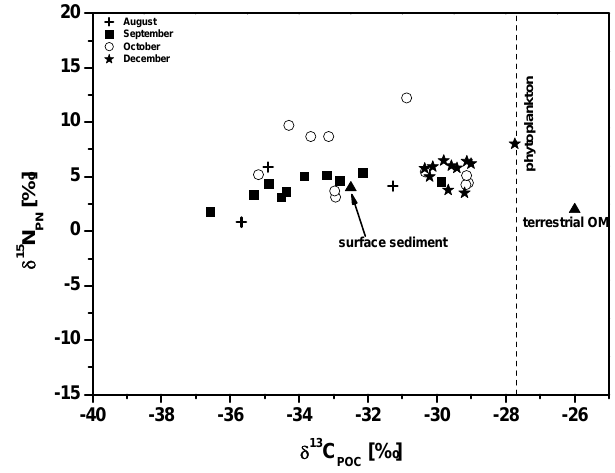
Fig. 4. Relationship between δ 15 N PN and δ 13 C POC in suspended particulate organic matter during all sampling periods, together with the isotope composition of sedimentary and terrestrial organic mat- ter and the isotope range of phytoplankton (˘Cermelj et al., 1996; Kendall et al.,